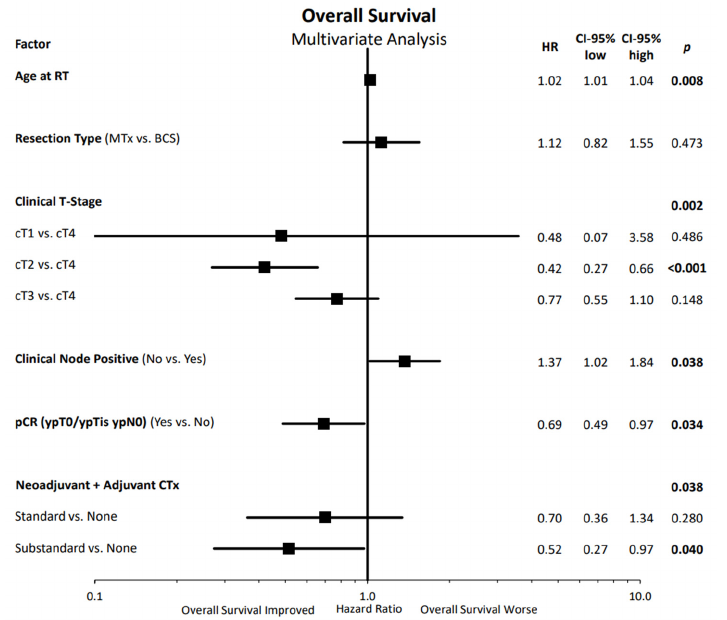
Figure 4. Multivariate Cox regression analysis of overall survival with hazard ratios and their corresponding confidence intervals presented in a forest plot. RT: radiotherapy, CTx: chemotherapy, BCS: breast-conserving surgery, MTx: mastectomy, pCR: pathologic complete response, T: tumor, G: grading, HR: hazard ratio, CI: confidence interval. Pathological complete response in the primary tumor and axillary lymph nodes was diagnosed in 106 patients (31.1%) with 15.4% in HR+ luminal A, 25.0% in HR+ luminal B, 30.8% in HR+/HER2+, 30.8% in HR − /HER2+ and 41.0% in triple-negative tumors. Statistically significant differences are marked in bold.